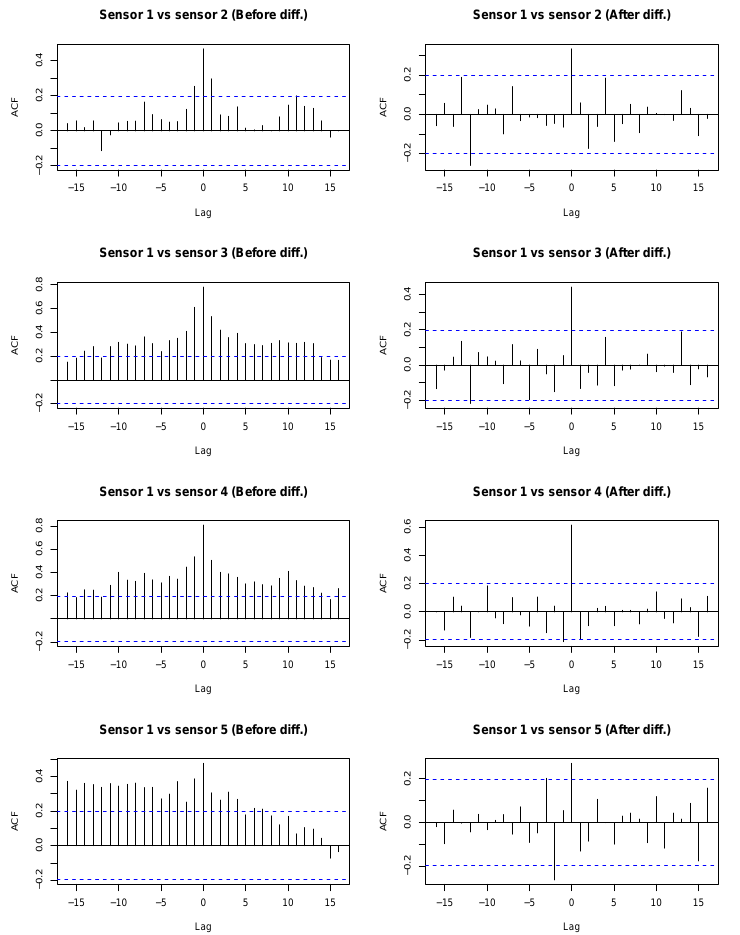
Figure 13. The SO 2 pollutant used as an example to show the high correlation at several lags, between the first sensor and the other four sensors (left-hand-side plots). This correlation was then reduced by differentiating the time series (right-hand-side